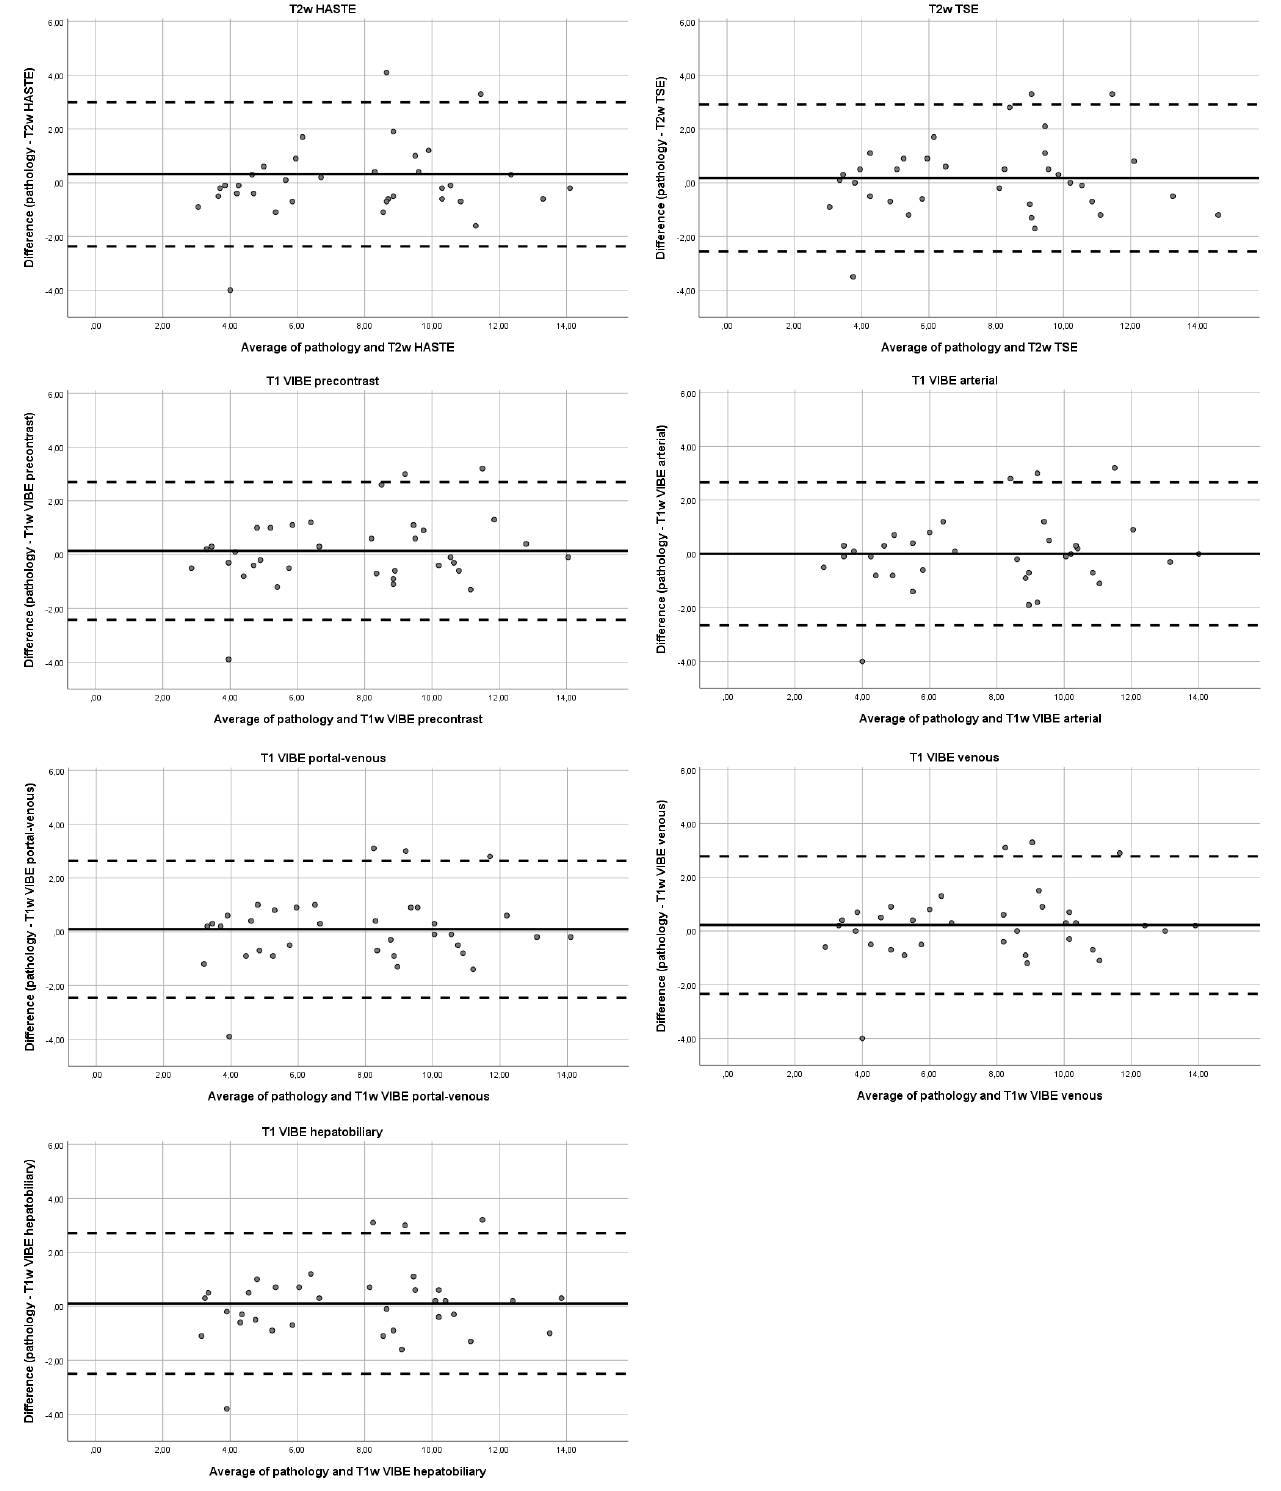
Figure 2. Bland–Altman plots of pathology vs. MRI sequences. Figure 2 shows the Bland–Altman plots of the average and difference of pathology versus the different MRI sequences.